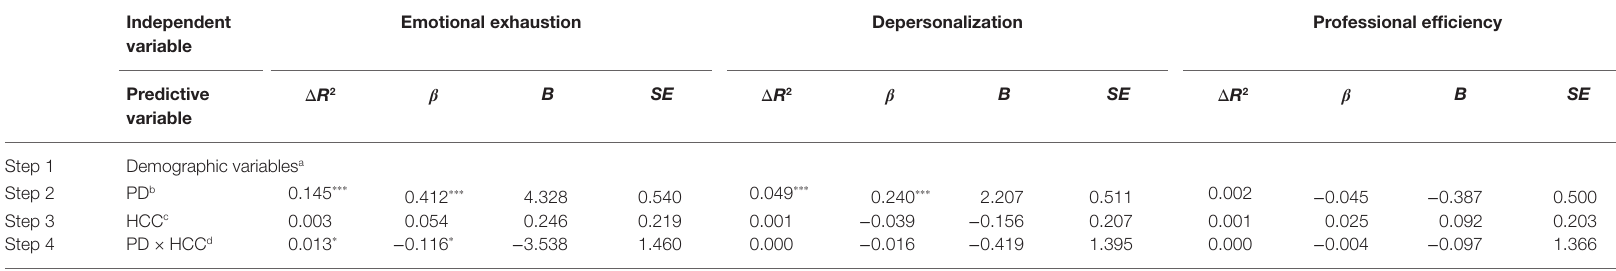
TABLE 3 | Multiple linear regression results of psychological demands, hair cortisol content, and their interaction against job burnouts ( n = 341). Independent Emotional exhaustion variable